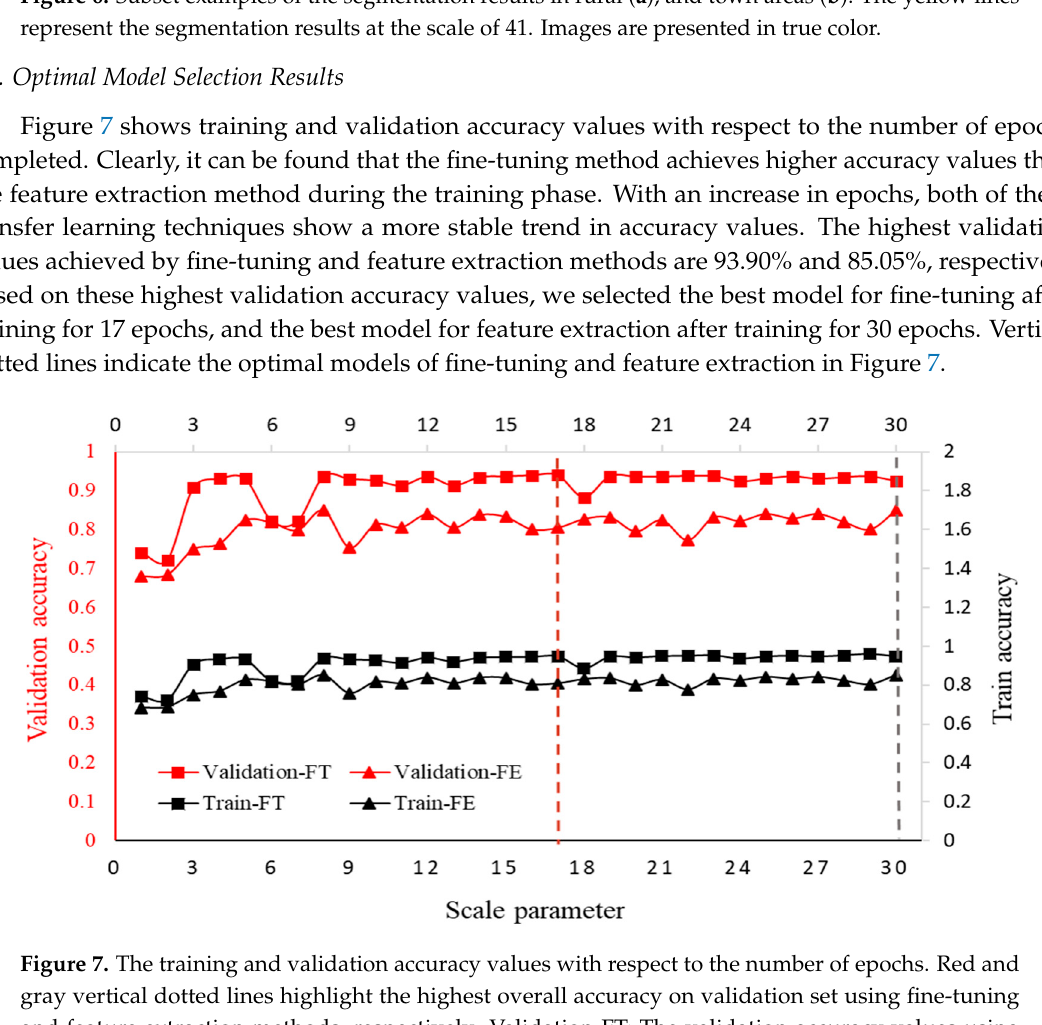
Figure 7. The training and validation accuracy values with respect to the number of epochs. Red and gray vertical dotted lines highlight the highest overall accuracy on validation set using fine-tuning and feature extraction methods, respectively. Validation-FT: The validation accuracy values using our proposed fine-tuning method. Validation-FE: The validation accuracy values using our proposed feature extraction method. Train-FT: The training accuracy values using our proposed fine-tuning method; Train-FE: The training accuracy values using our proposed feature extraction method.